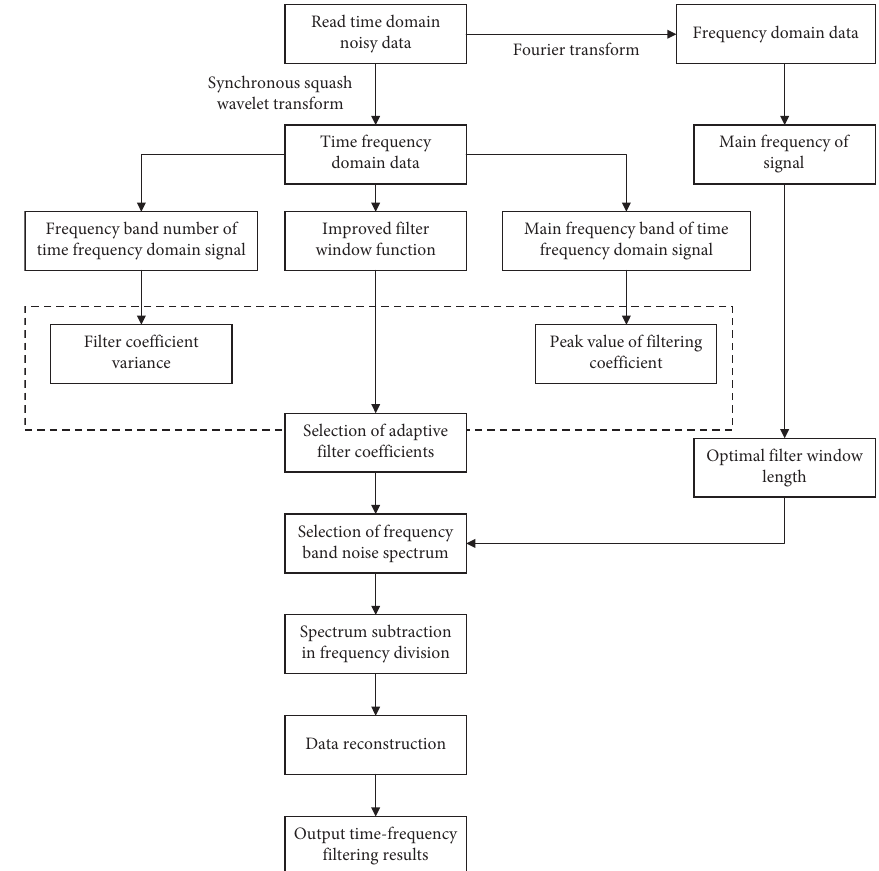
Figure 1: Flow of time-frequency spectral subtraction (TF-SS).